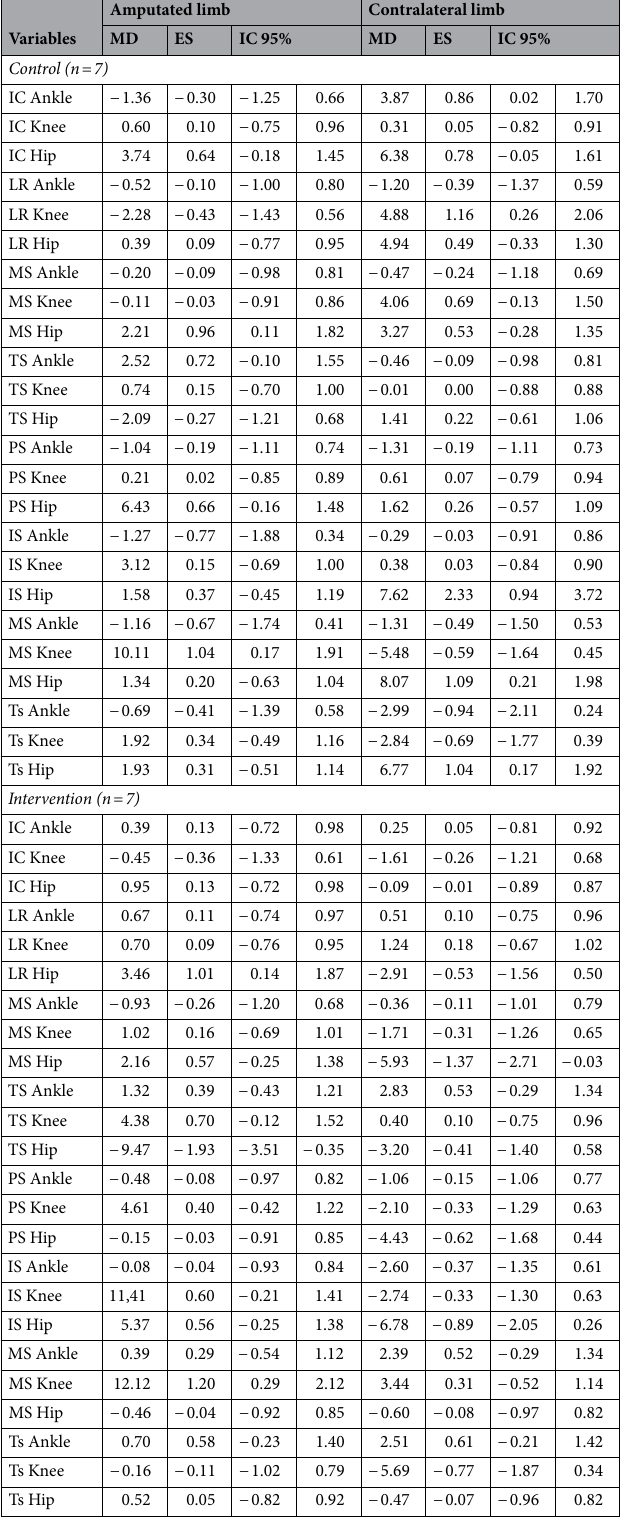
Table 4. Analysis of the magnitude of the intervention effects on ankle, knee, and hip joint angles (º) in the sagittal plane during different phases of gait cycle. MD: Mean difference; ES: Effect size; 95% CI: 95% confidence interval. Phases of the gait cycle are abbreviated as: IC (0–2% GC)—Initial contact; LR (0–10% GC)—Loading response; MS (10–30% GC) – Mid stance; TS (30–50% GC) – Terminal stance; PS (50–60% GC)—Pre-swing; IS (60–73% GC)—Initial swing; MS (73–87% GC) – Mid swing; Ts (87–100% GC) – Terminal swing. Dorsiflexion ( +) and plantar flexion of the ankle (-); Flexion ( +) and extension of the knee (-); Flexion ( +) and extension (-) of the